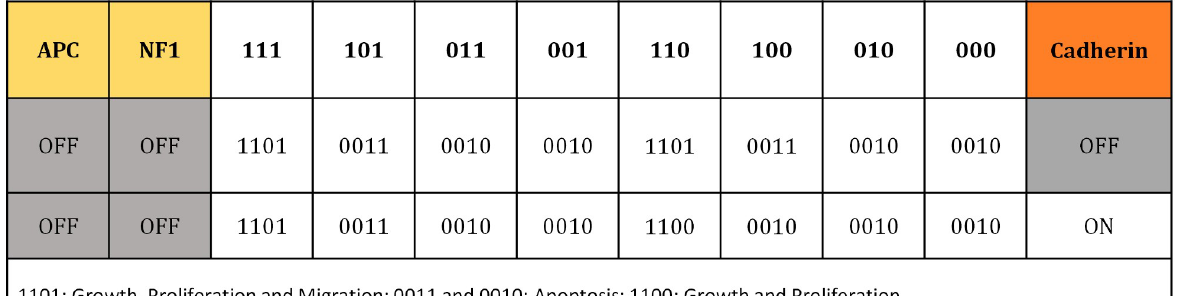
Fig 3. Boolean model prediction of cell phenotype (state) for various input configurations. Colors correspond to the color of the nodes in Fig 2, indicating activity of the receptors’ signal (i.e. integrin, RTK, Wnt) and inactivation of receptor is shown in grey. Tumor suppressors are deactivated. For instance, if the cell receives a signal from integrin and RTK, and no signal from Wnt (110), considering cadherin activation, the model predicts that the cell starts to grow and proliferate (1100). The binary code on the first row specify the integrin, RTK and Wnt states, respectively.